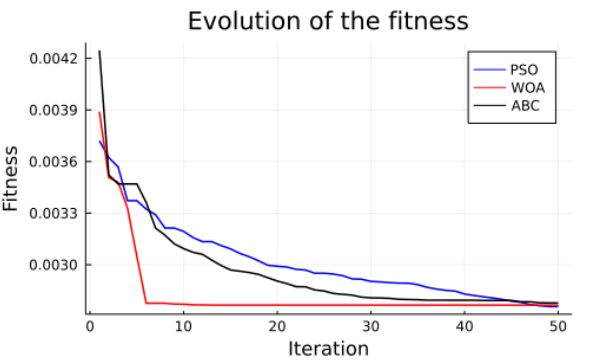
Figure 4. The fitness evolution for the PSO, WOA, and ABC algorithms.